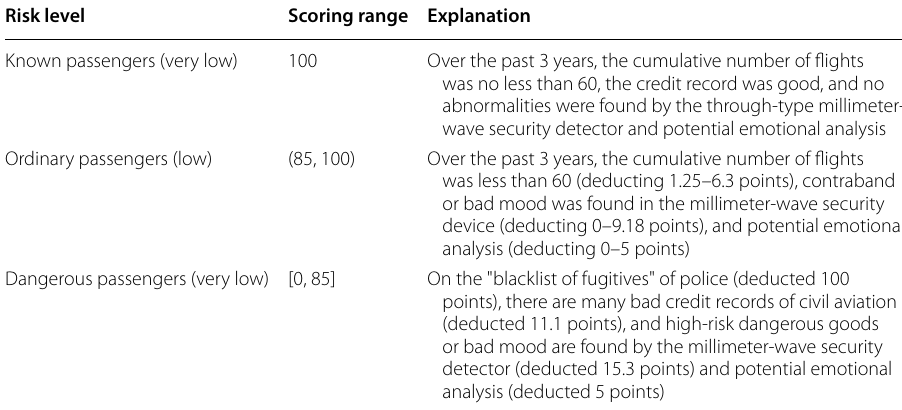
Table 10 Risk classification criteria Risk level Scoring range